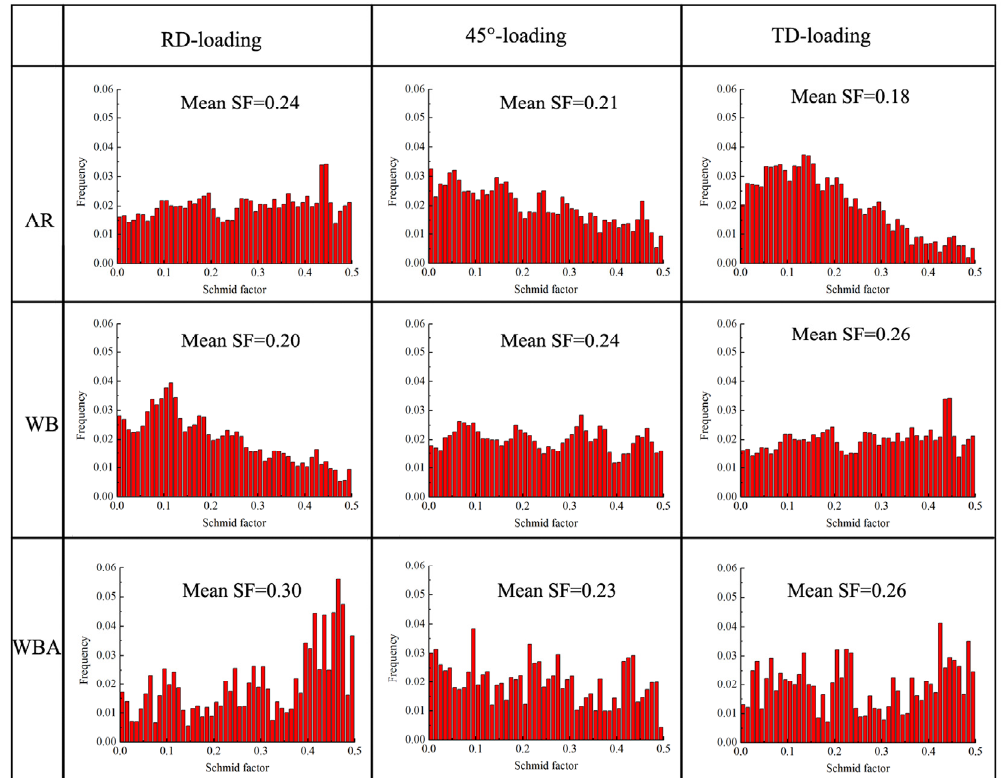
Figure 9. Frequency of the Schmid factor for basal slip in various samples.